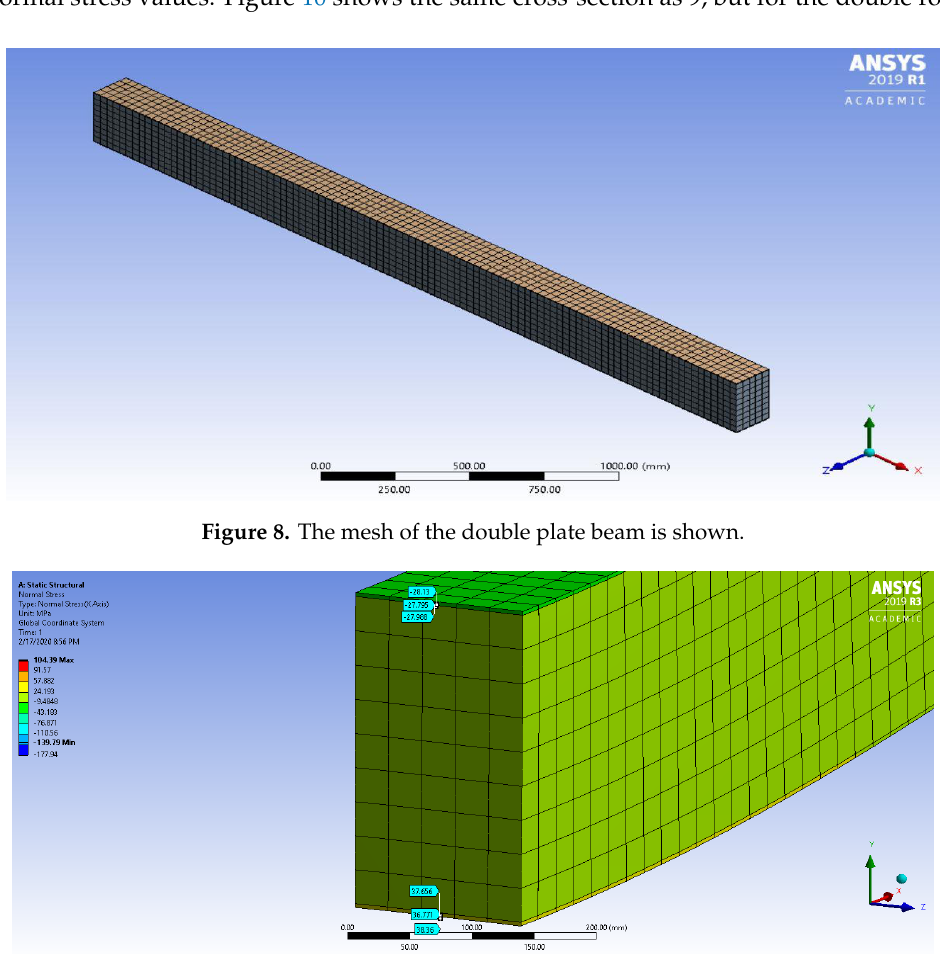
Figure 9. A section cut near the center of the beam for the double-plate configuration with glass reinforcement in the top plate and steel in the bottom. Probe values are shown in MPa.